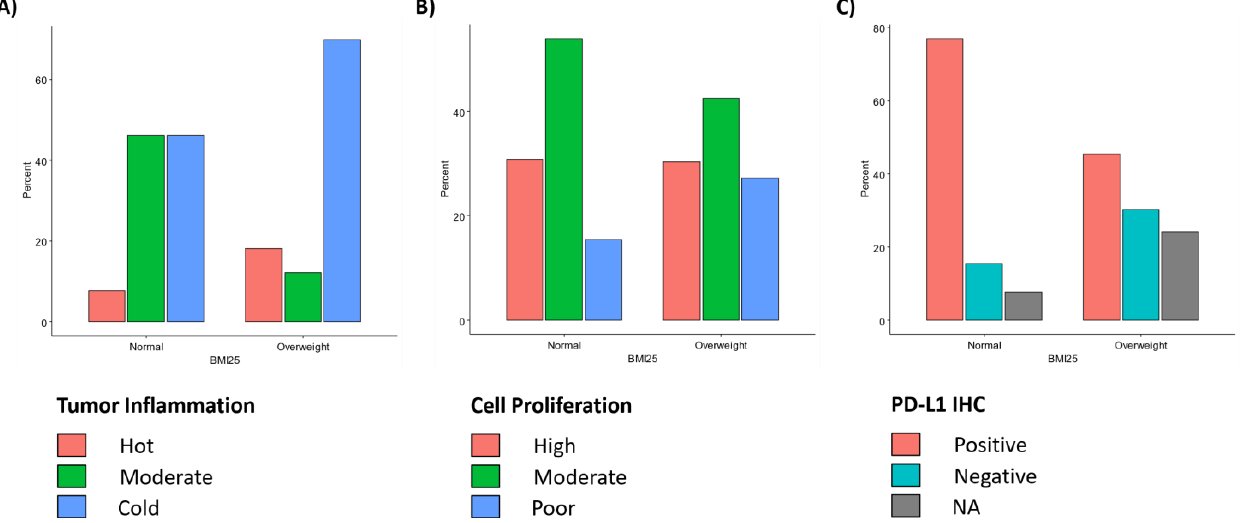
Figure 3. Proportions of ( A ) inflammation, ( B ) cell proliferation and ( C ) PD-L1 IHC biomarker in two BMI groups.